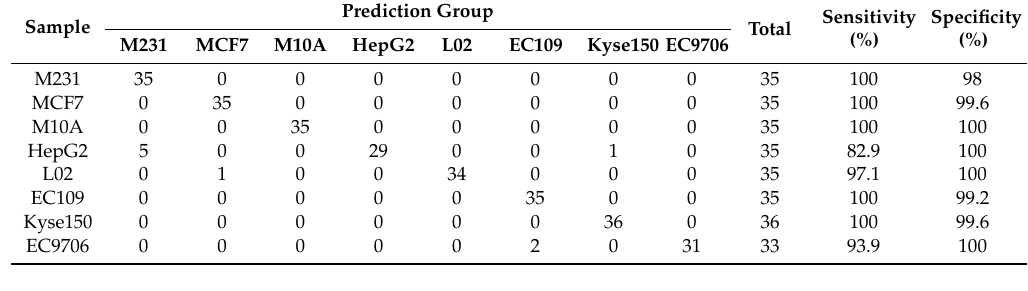
Table 4. PCA-LDA classification of subtypes of exosomes derived from di ff erent cancer sources.